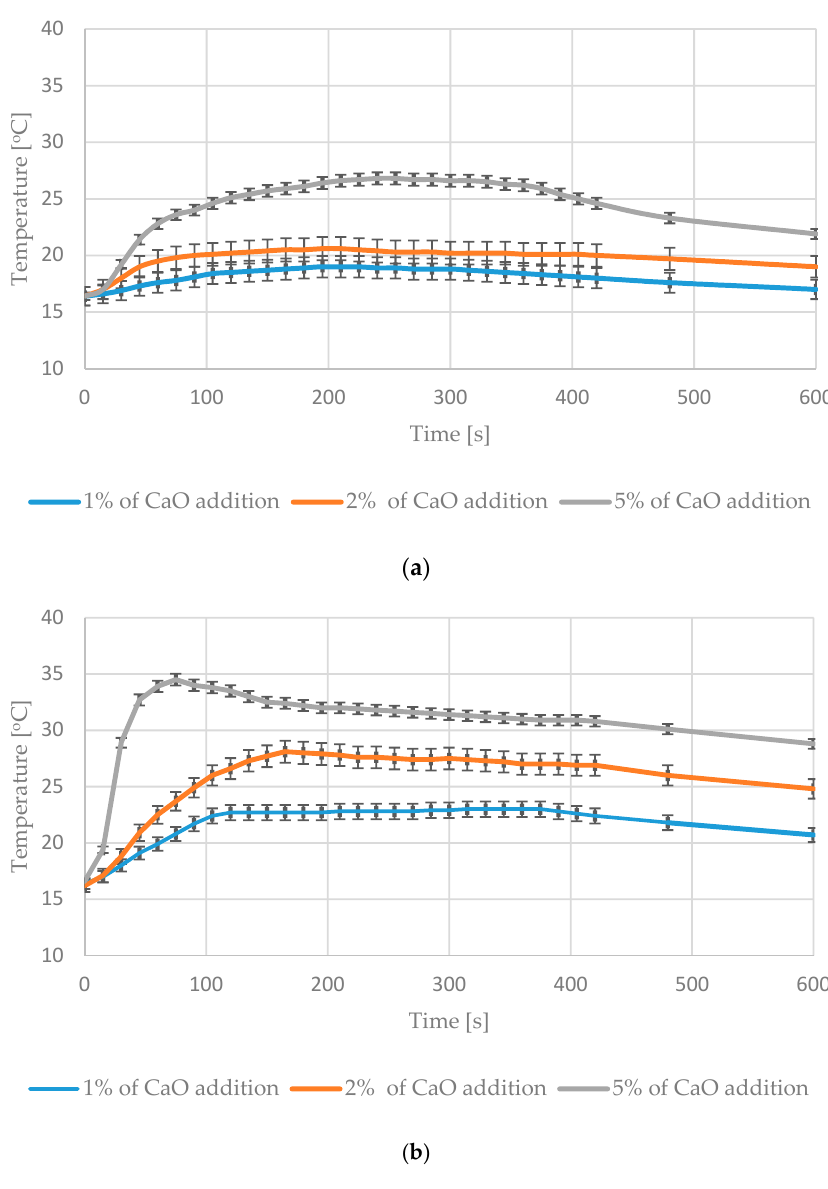
Figure 4. Temperature changes during mixing of materials: ( a ) RDF with 20% moisture content and different mass additions of CaO, ( b ) RDF with 30% moisture content and different mass additions of CaO.